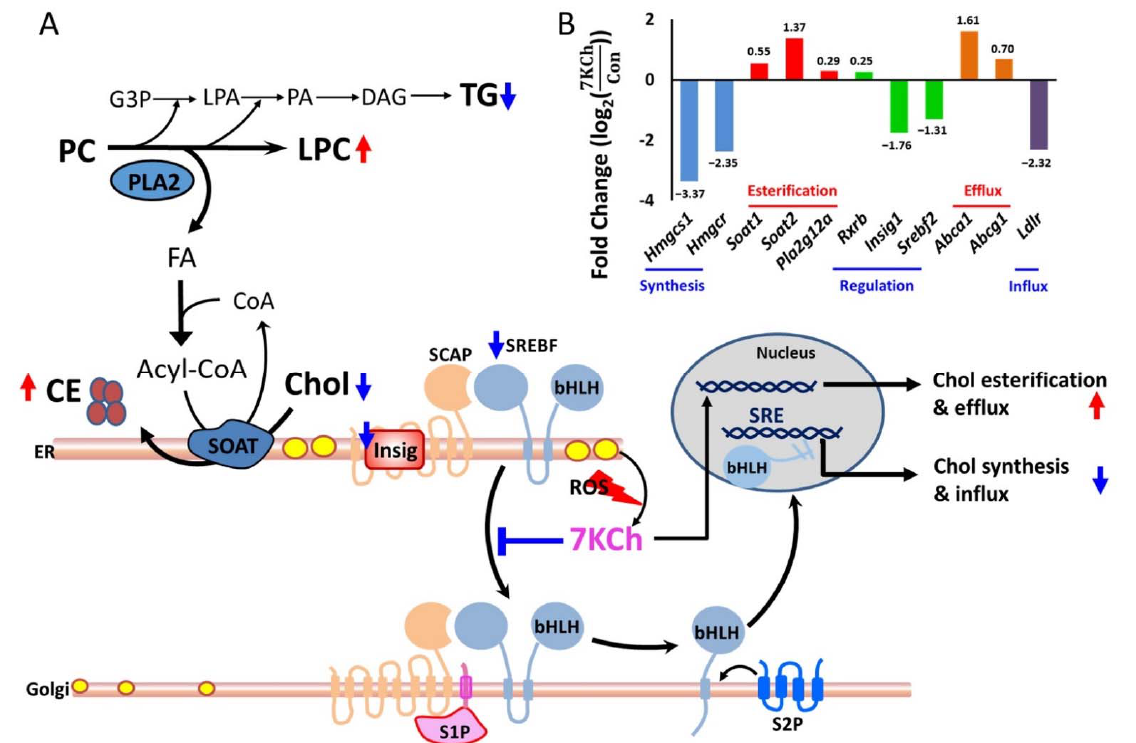
Figure 6. A schematic diagram illustrating 7KCh-induced remodeling of lipid metabolism in HL-1 cells. (A) 7KCh inhibits TG biosynthesis and activates PLA2 to release fatty acid (FA) from phospholipids (e.g., PC). This provides FA for the esterification of Chol (yellow oval) to form CE (brown oval). 7KCh inhibits cleavage and activation of